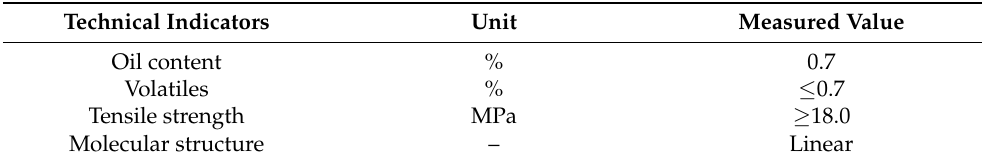
Table 3. Basic technical parameters of SBS modifier.